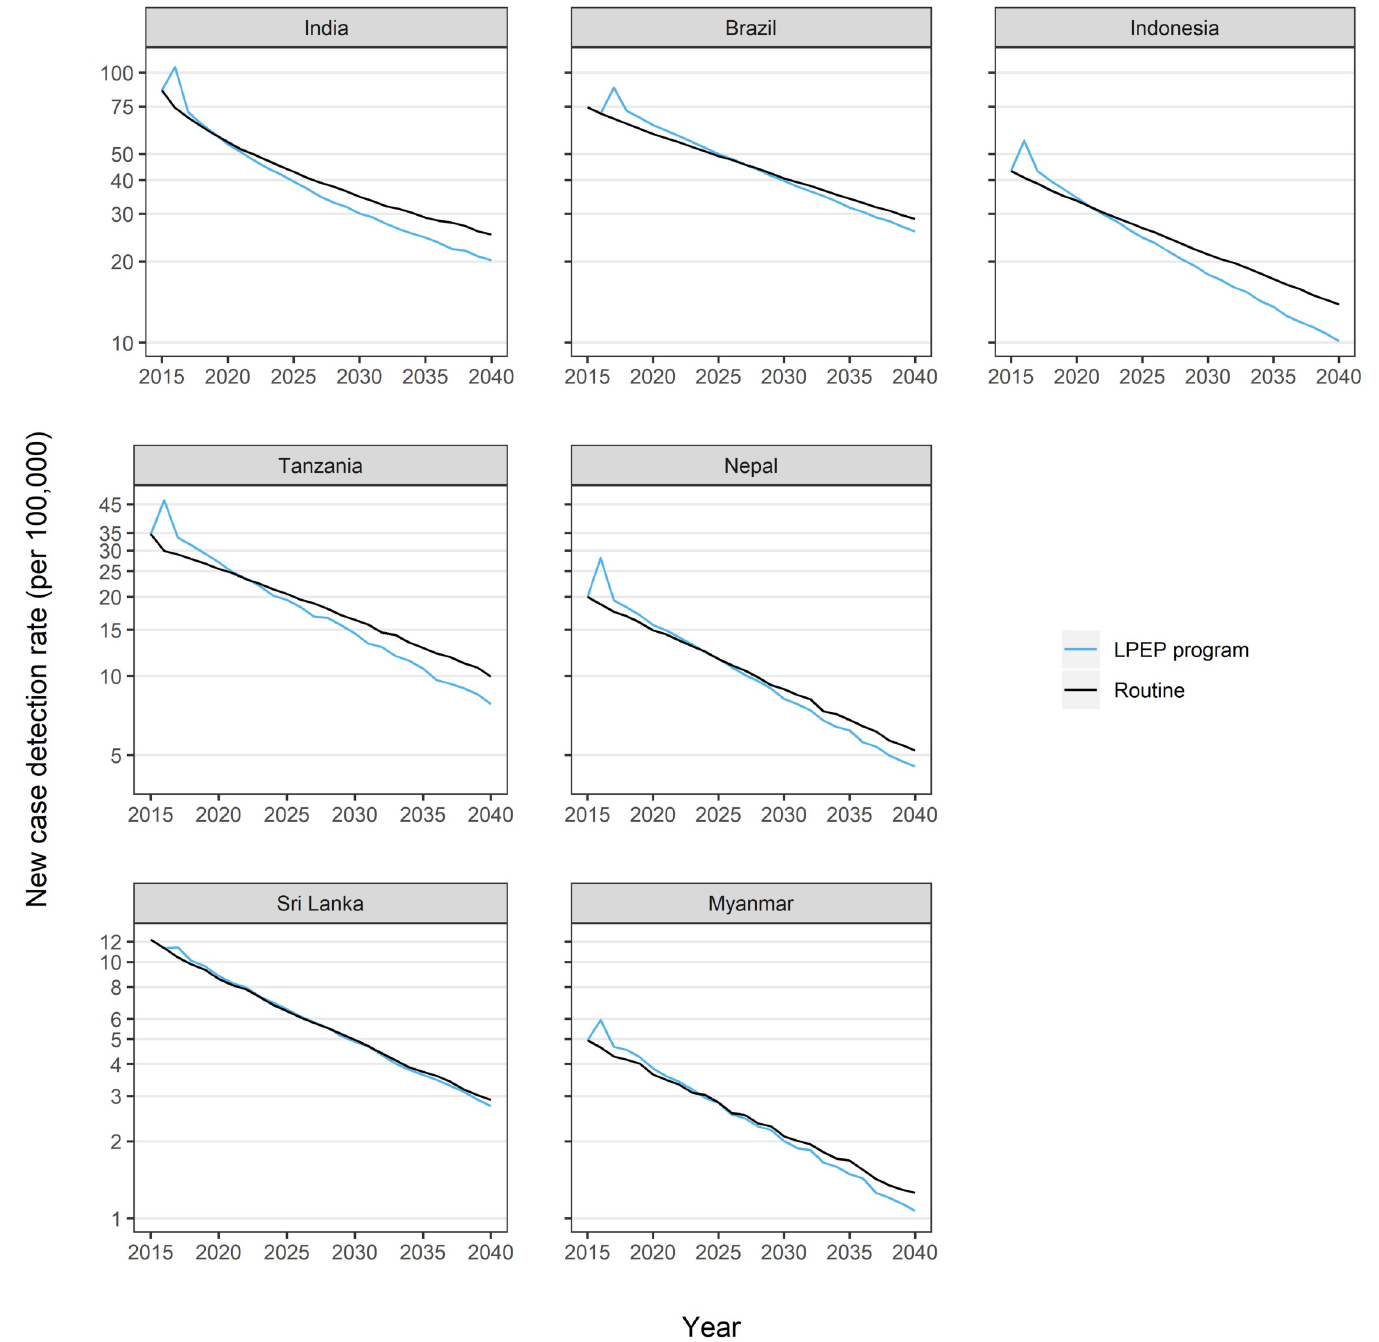
Fig 2. Predicted long term trends of the leprosy new case detection rate under the routine programme, and combined with the LPEP program, stratified by LPEP area. Each panel represents the trends in subnational states or districts (arranged in descending order of baseline endemicity level): India (Union Territory Dadra and Nagar Haveli); Brazil (Alta Floresta city and region and Rondono´polis city in Mato Grosso, Araguaı´na and Colinas do Tocantins in Tocantins, Petrolina city and region in Pernambuco); Indonesia (Sumenep district); Tanzania (Kilombero, Liwale and Nanyumbu); Nepal (Jhapa, Morang and Parsa districts); Sri Lanka (Kalutara and Puttalam districts); Myanmar (Nyaung Oo, Myingyan and Tharyarwaddy Townships). Model predictions are represented by means of 1,000 repeats (solid line). The blue line represents the LPEP program and the black line the routine programme.